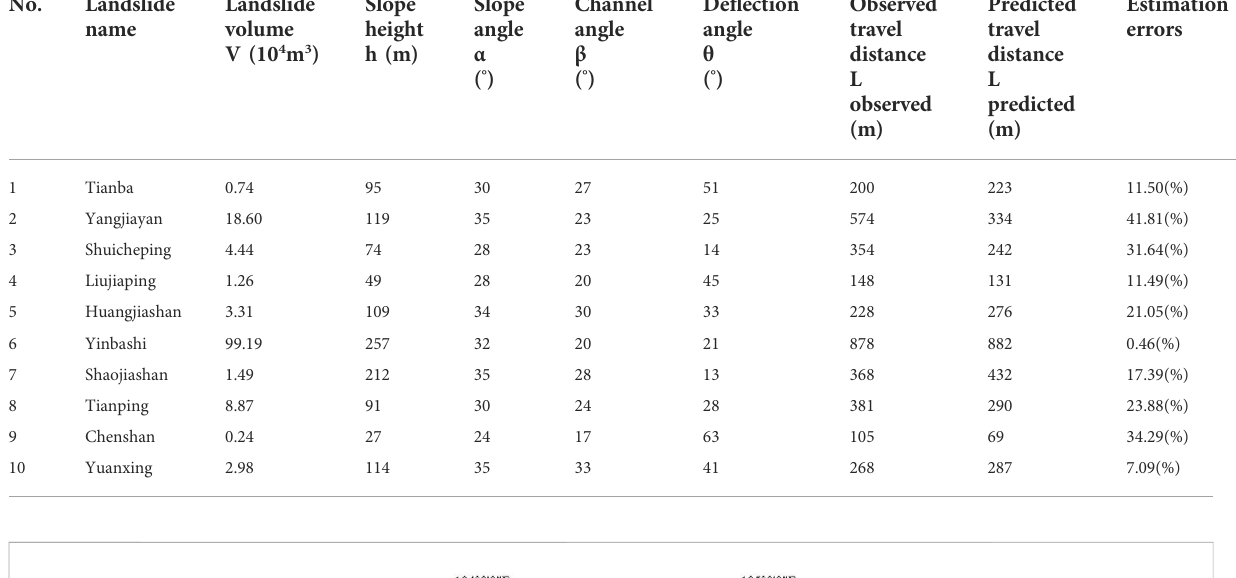
TABLE 3 Database of de fl ection-type rock avalanches used for applicability veri fi cation of the improved empirical model. No.